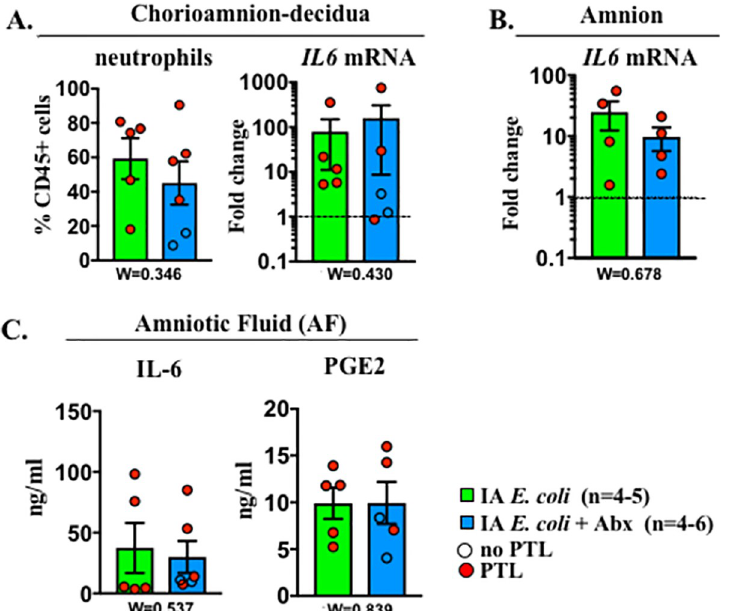
Fig 4. Abx treatment did not decrease E . coli –induced inflammation. The comparison groups are IA E . coli without Abx (green bar) and IA E . coli with Abx (blue bar). Red circles denote animals with PTL, while clear circles denote animals without PTL. Values were expressed as fold change value for the IA saline control group. Comparison of (A) chorio-amnion decidua neutrophil frequency and IL6 mRNA, (B) amnion IL6 mRNA, and (C) AF IL6 and PGE2. Dashed line represents the mean value of ctrl animals. Data are mean, SEM. Wilcoxon test (W) comparing the 2 groups was applied, and p -values are shown under each panel. See S1 Data for numerical values. Abx, antibiotics; AF, amniotic fluid; IA, intra-amniotic; IL-6, interleukin 6; PGE2, prostaglandin E2; PTL, preterm labor.